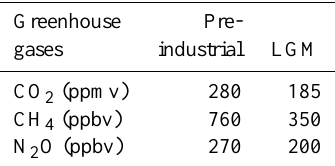
Table 2. Atmospheric greenhouse gas concentrations for the PI and LGM time